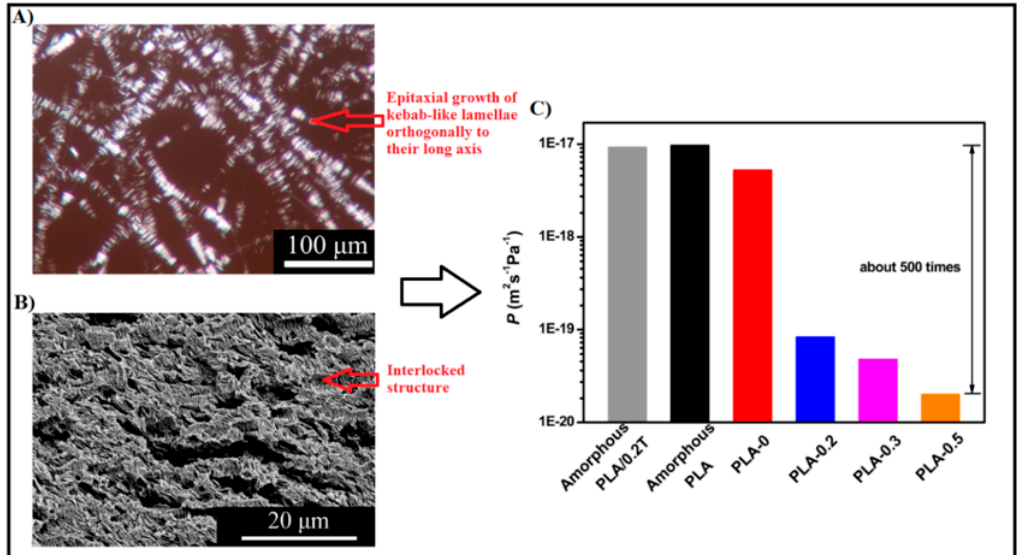
Figure 6. ( A , B ) POM and cross-sectional micrograph of crystal morphology for PLA with a nucleating agent showing an epitaxial growth lamellae and interlocked structure, respectively; ( C ) Oxygen permeability coefficient ( p ) values for all PLA samples as a function of nucleating agent content. Adapted from [125] with permission from American Chemical Society. Copyright © 2014.